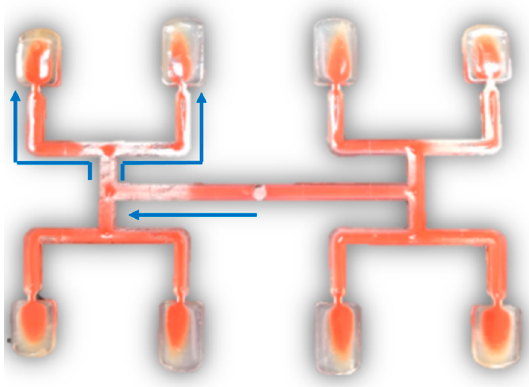
Figure 1. Filling imbalance in geometrically balanced injection molds.